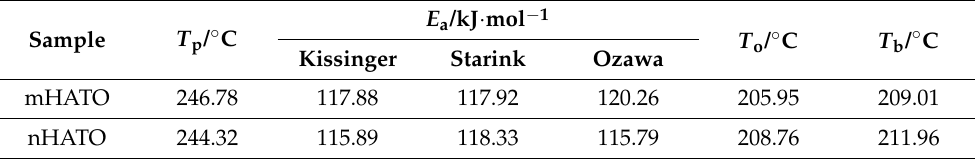
Figure 5. Principle diagram of nHATO grinding. Reproduced from [48], with permission from Chinese Journal of Explosives and Propellants (Huo Zha Yao Xue Bao), 2019. Table 1. Properties of nHATO and mHATO.